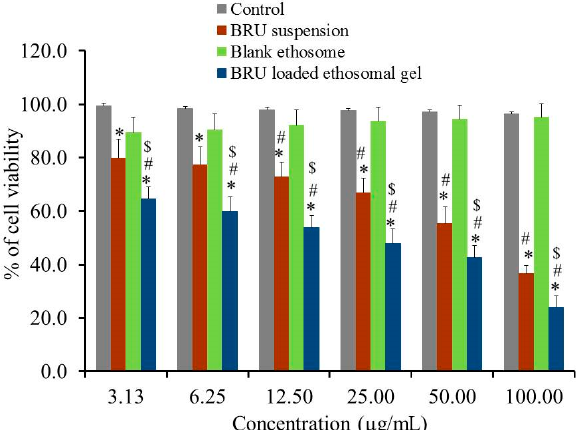
Figure 9. In-vitro cytotoxicity study of BRU suspension. Blank ethosome and BRU loaded ethosomal gel against A 375 cell line for 48 h. Data are expressed as mean ± SD ( n = 3). * p < 0.05 comparable to control, # p < 0.05 comparable to blank ethosome and $ p < 0.05 comparable to BRU suspension.